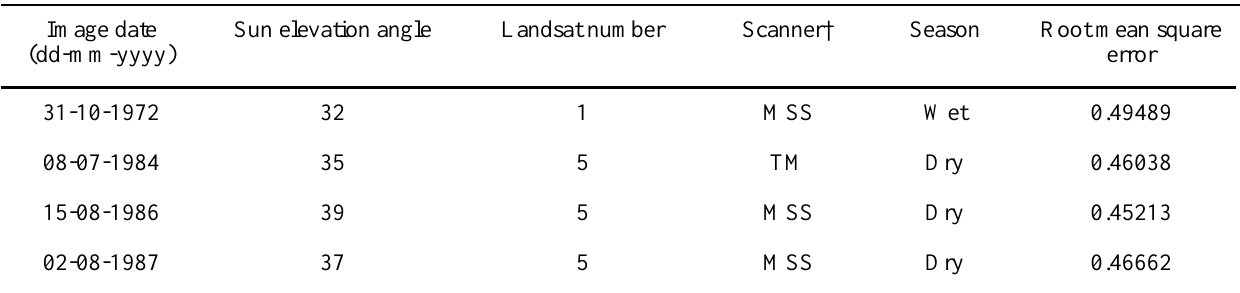
Table 2. Characteristics of the Landsat satellite data